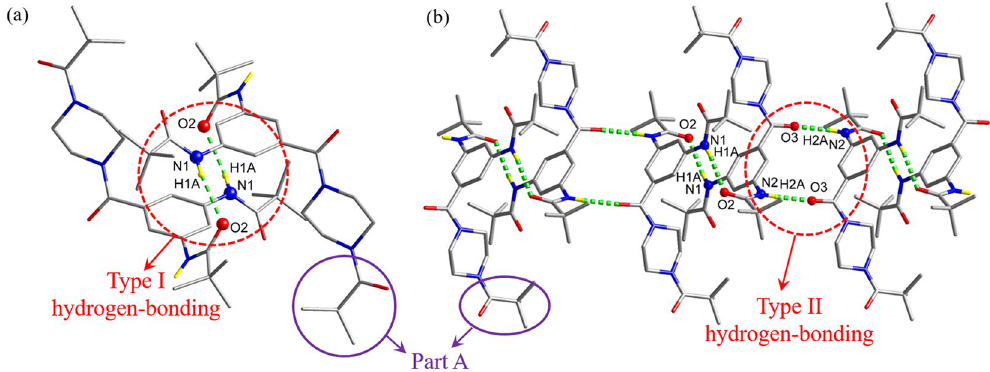
Figure 7. ( a ) Type I H-bond interaction and ( b ) type II H-bond interaction in 1